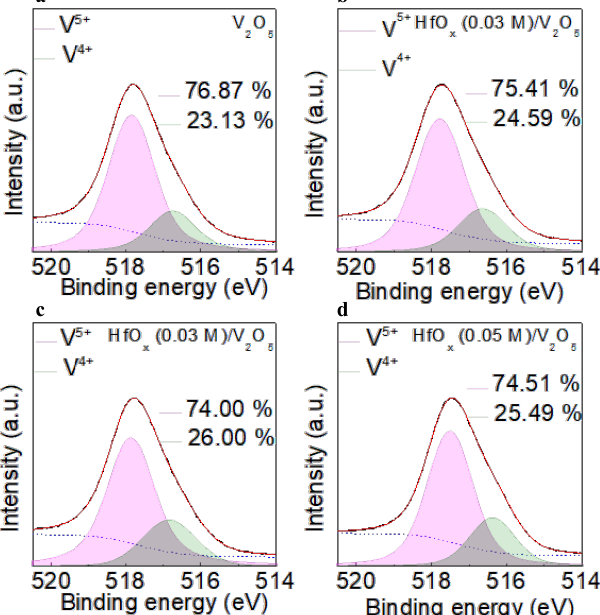
Figure 4. Deconvoluted V 2p 3/2 XPS results of the ( a )V 2 O 5 , ( b ) HfO x (0.01 M)/V 2 O 5 , ( c ) HfO x (0.03 M)/V 2 O 5 , and ( d ) HfO x (0.05 M)/V 2 O 5 films.